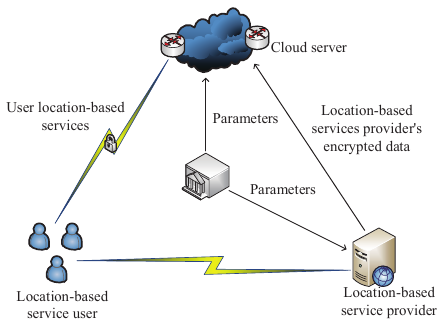
Figure 12. The architecture of the secure polygon spatial query scheme.